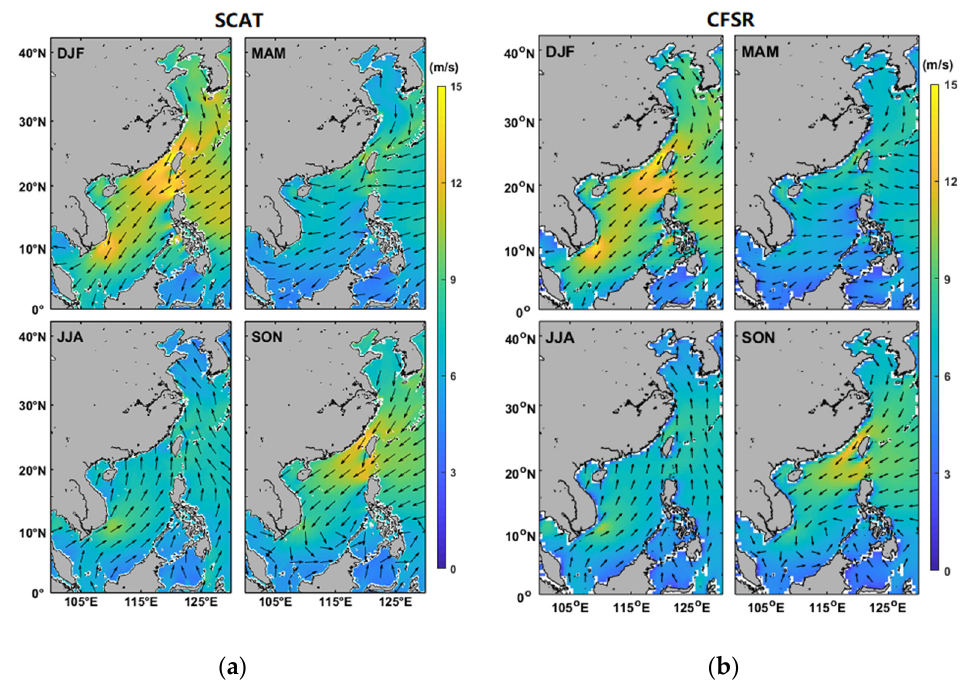
Figure 6. Seasonal variation in winds at 70 m above sea surface between 2000 and 2016 calculated from the combined scatterometer wind product ( a ) and CFSR data ( b ) in winter (DJF), spring (MAM), summer (JJA), and autumn (SON).